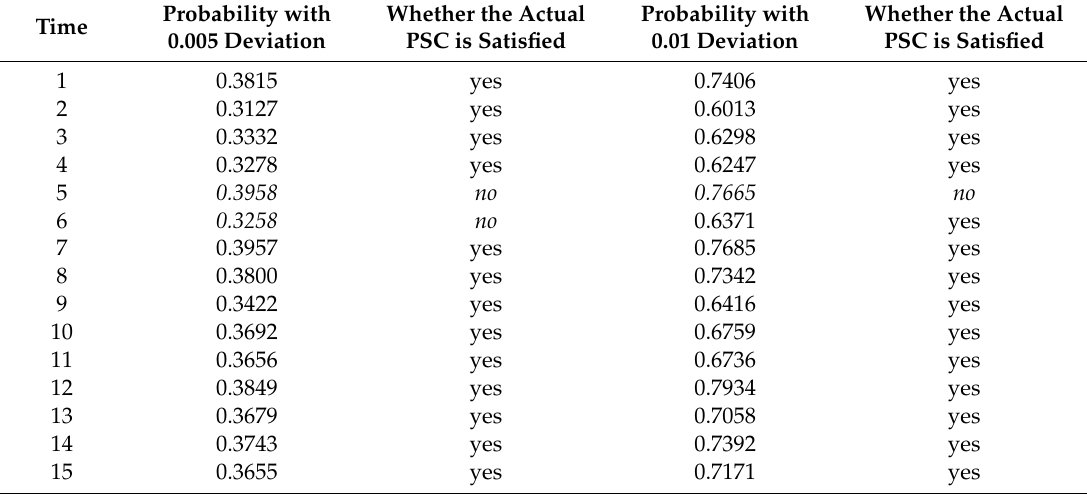
Table 7. Probability and actual situation of power supply capability range.